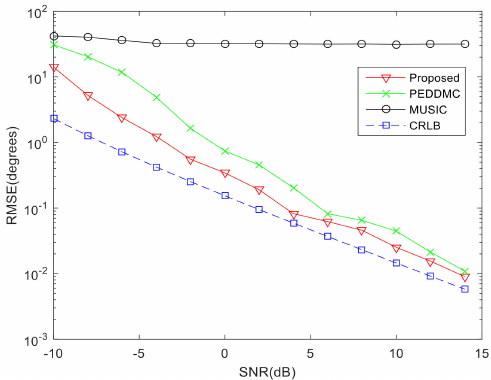
Figure 7. Comparison of DOA estimation performance versus SNR.